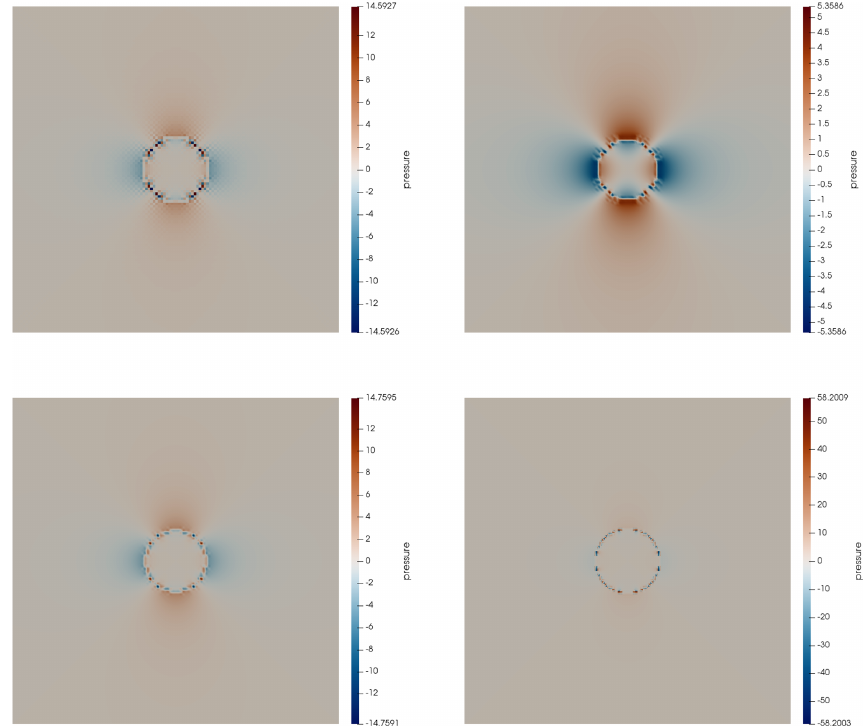
Figure 9. SolVi benchmark. Pressure field for the Q 1 × P 0 , stabilized Q 1 × Q 1 , Q 2 × Q 1 , and Q 2 × P − 1 elements from left to right and top to bottom at resolution 128 × 128 with no averaging. Note the different color scales, illustrating the differing size of overshoots and undershoots for the different discretizations.